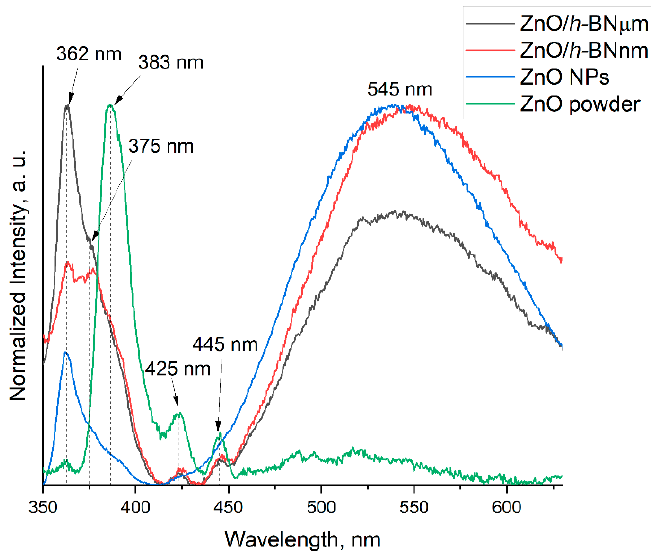
Figure 5. PL spectra of ZnO/ h -BN samples in comparison with ZnO micron powder and ZnO NPs.